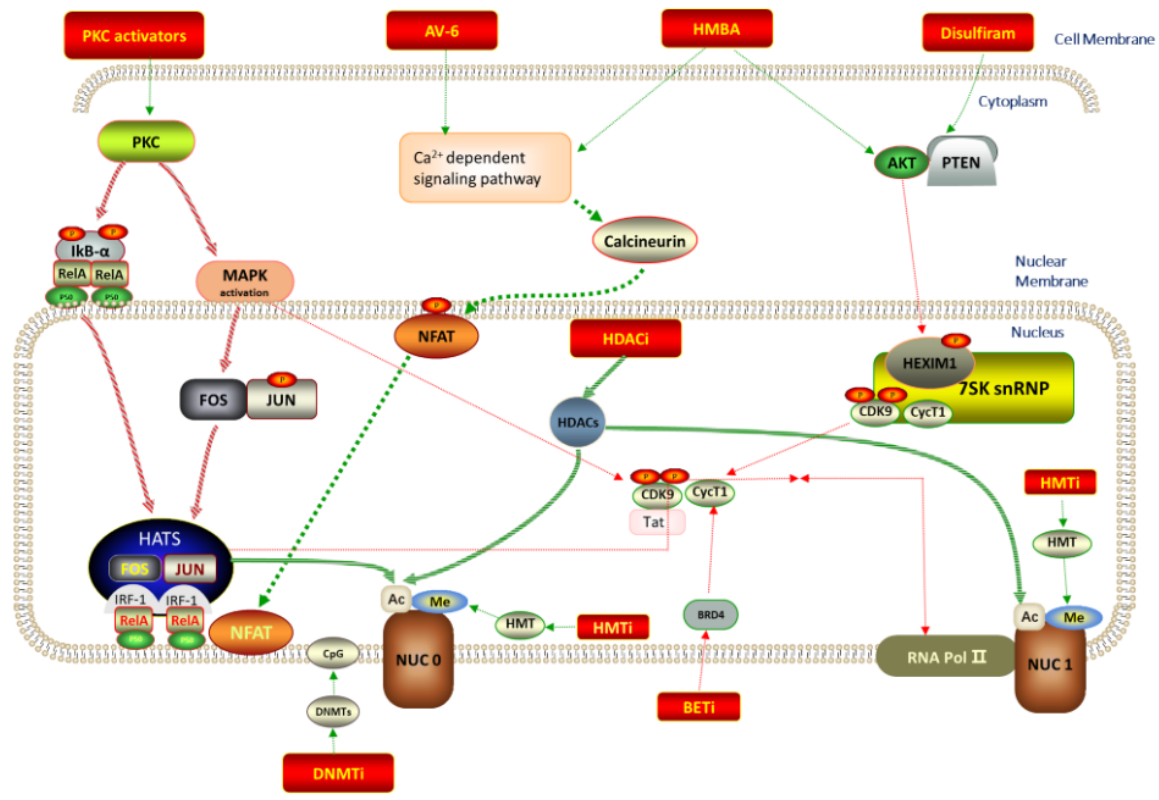
Figure 1. Schematic overview of molecular mechanisms of latent viral reservoirs and corresponding LRAs.